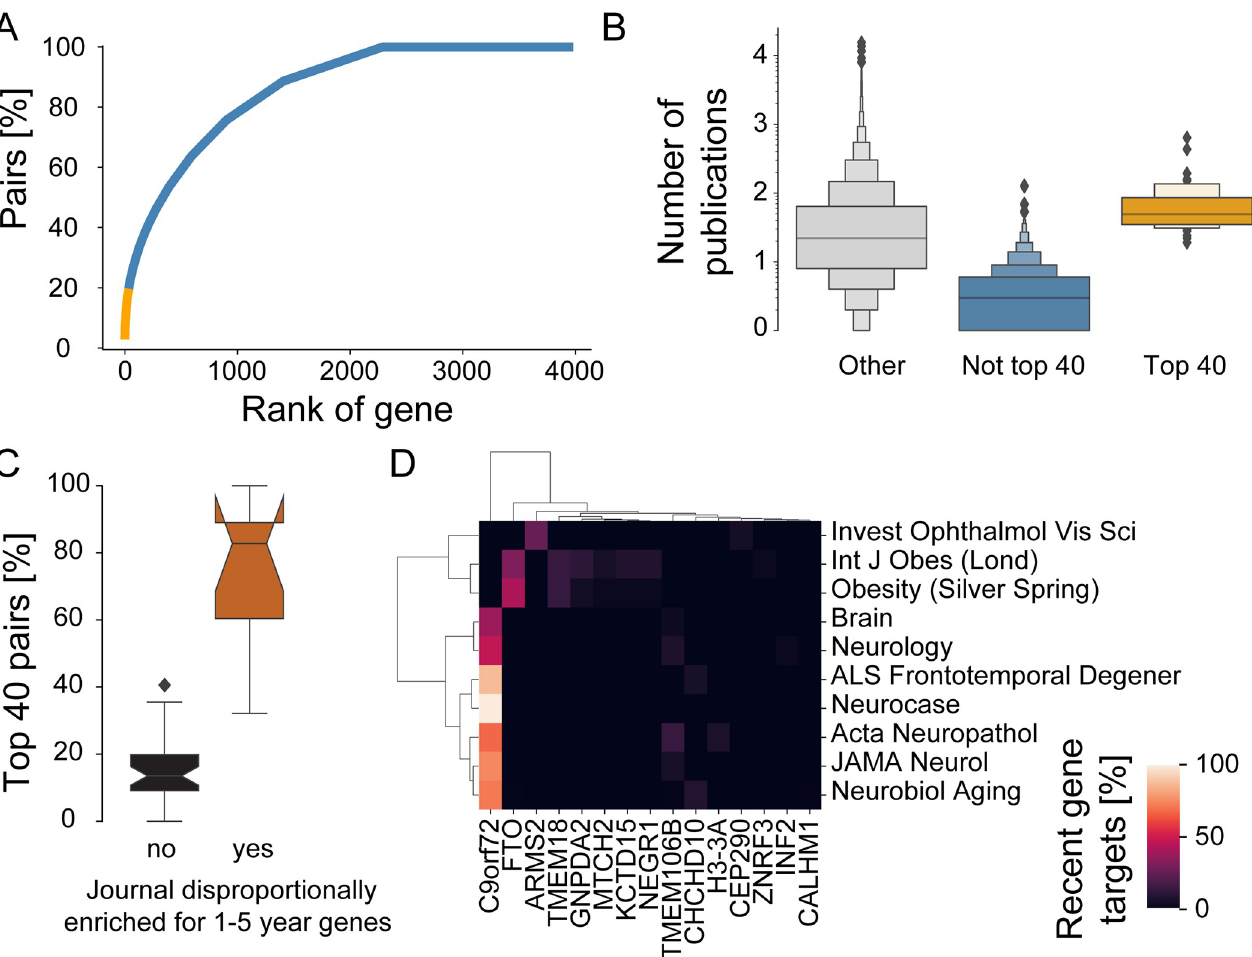
Fig 6. Early-stage research focuses on a handful of genes and is driven by specific domains. (A) Cumulative distribution of pairs of highlighted genes and 2010 to 2018 publications highlighting recent gene targets (first highlighted 1 to 5 years before). The x-axis ranks genes by number of publications highlighting them, with rank 0 corresponding to the gene highlighted in the most publications. The y-axis tallies the percentage of all pairs of highlighted genes and 2010 to 2018 publications highlighting recent gene targets with a lower or equal rank. We emphasize in orange the top 1% genes (40 genes), which together account for 21% of all pairs. Note that for simplicity of data representation, we allow for overlapping and shifting time windows. For example, a gene that has been first highlighted 5 years prior the start the indicated decade would will only be represented by a single year in our analysis. (B) Letter plot of all highlighted genes reporting for each gene the total number of publications until 2018 for genes that still were a recent target during the time 2010 to 2018 period, but were not (“Not top 40,” blue) or were in the “top 40” (“Top 40,” orange) and “other” genes (gray). Area of boxes indicates share of values, with heights of boxes following letter style dimensions (innermost boxes contain 25 to 75 percentiles of values and subsequent boxes 12.75 to 87.5 percentiles of values, etc.). Note that for 2010 to 2018, “other” is practically synonymous with genes first highlighted before 2005. Note further that some the genes of the “Not top 40” category may still accrue more publications until 2018, the final year of our analysis given the presence of shifting time windows. (C) Journals that enrich for top recent gene targets preferentially highlight top 40 genes. Percentage of pairs of publications and recent gene targets that fall onto the top 40 recently highlighted genes. Journals are considered to disproportionally enrich for recent gene targets if they enrich for recent gene targets at least twice as much as they enrich for novel gene targets (above dashed line in Fig 3C). (D) Different top 40 genes are highlighted in publications from journals dedicated to different fields. The heatmap plot shows the percentage of publications highlighting a given recently highlighted gene from among all publications in the given journal. Shown are journals that highlight recent gene targets and enrich for recent gene targets at least twice as much as they enrich for novel gene targets (above dashed line in Fig 3C). Genes and journals are ordered and grouped using Ward clustering. Combines data from MEDLINE, NCBI gene and taxonomy information, gene2pubmed, and PubTator. For data underlying the figure, see